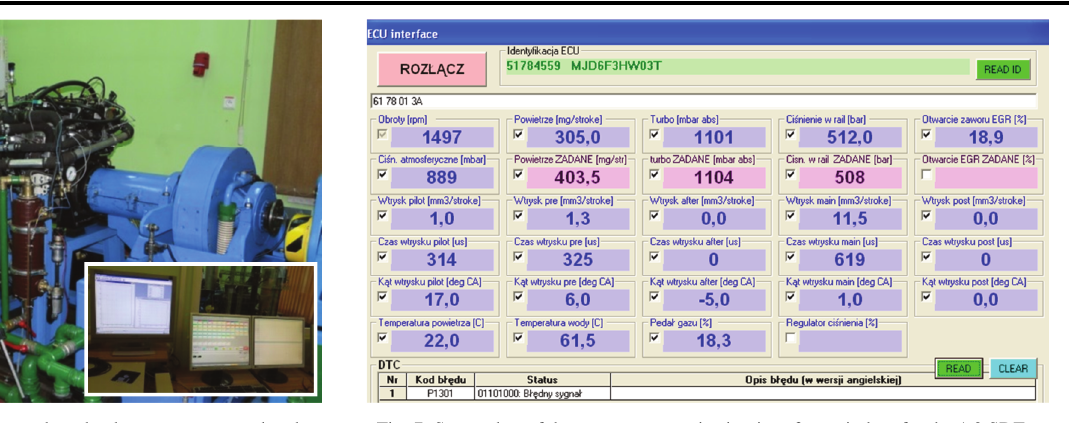
Fig. 7. Screenshot of the parameter monitoring interface window for the 1.3 SDE engine control [7]